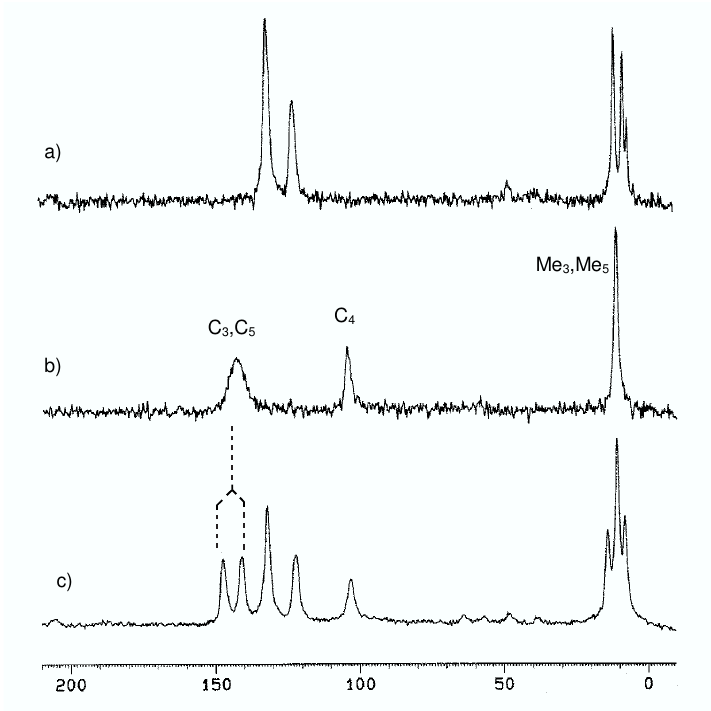
Fig. 3 13 C CPMAS NMR spectra of a) 4,5-dimethylimidazole ( 4 ), b) 3,5-dimethylpyrazole ( 1 ), c) A 1:1 mixture of 1 + 4